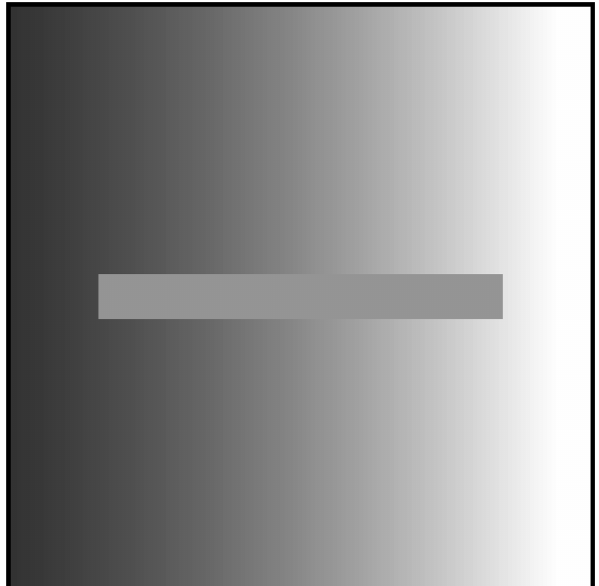
Figure 5. Example of environment contrast. The central bar may seem to be a gradient, but it is uniform in shade. Cover the surround- ing (real) gradient with paper of uniform colour to demonstrate